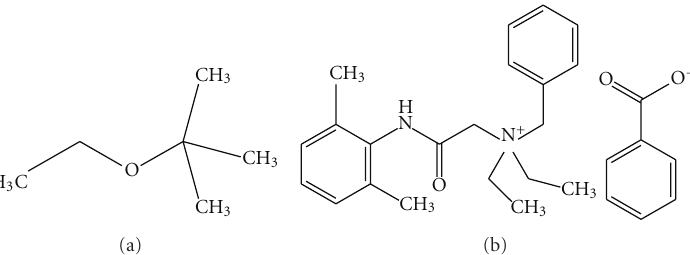
Figure 1: Chemical structures of tert-butyl ethyl ether (ETBE) (a) and denatonium benzoate (phenylmethyl-[2-[(2,6-dimethylphen- yl)amino]-2-oxoethyl]-diethylammonium benzoate, Bitrex) (b).